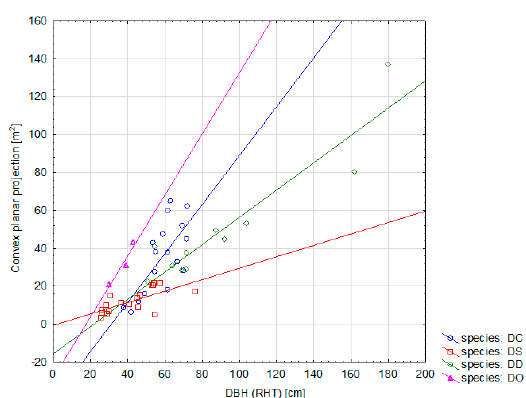
Figure 7. Convex planar projection compared to the stem diameter at breast height (DBH). Key: DC — Dracaena cinnabari; DS—D. serrulata; DD—D. draco; DO—D. ombet.